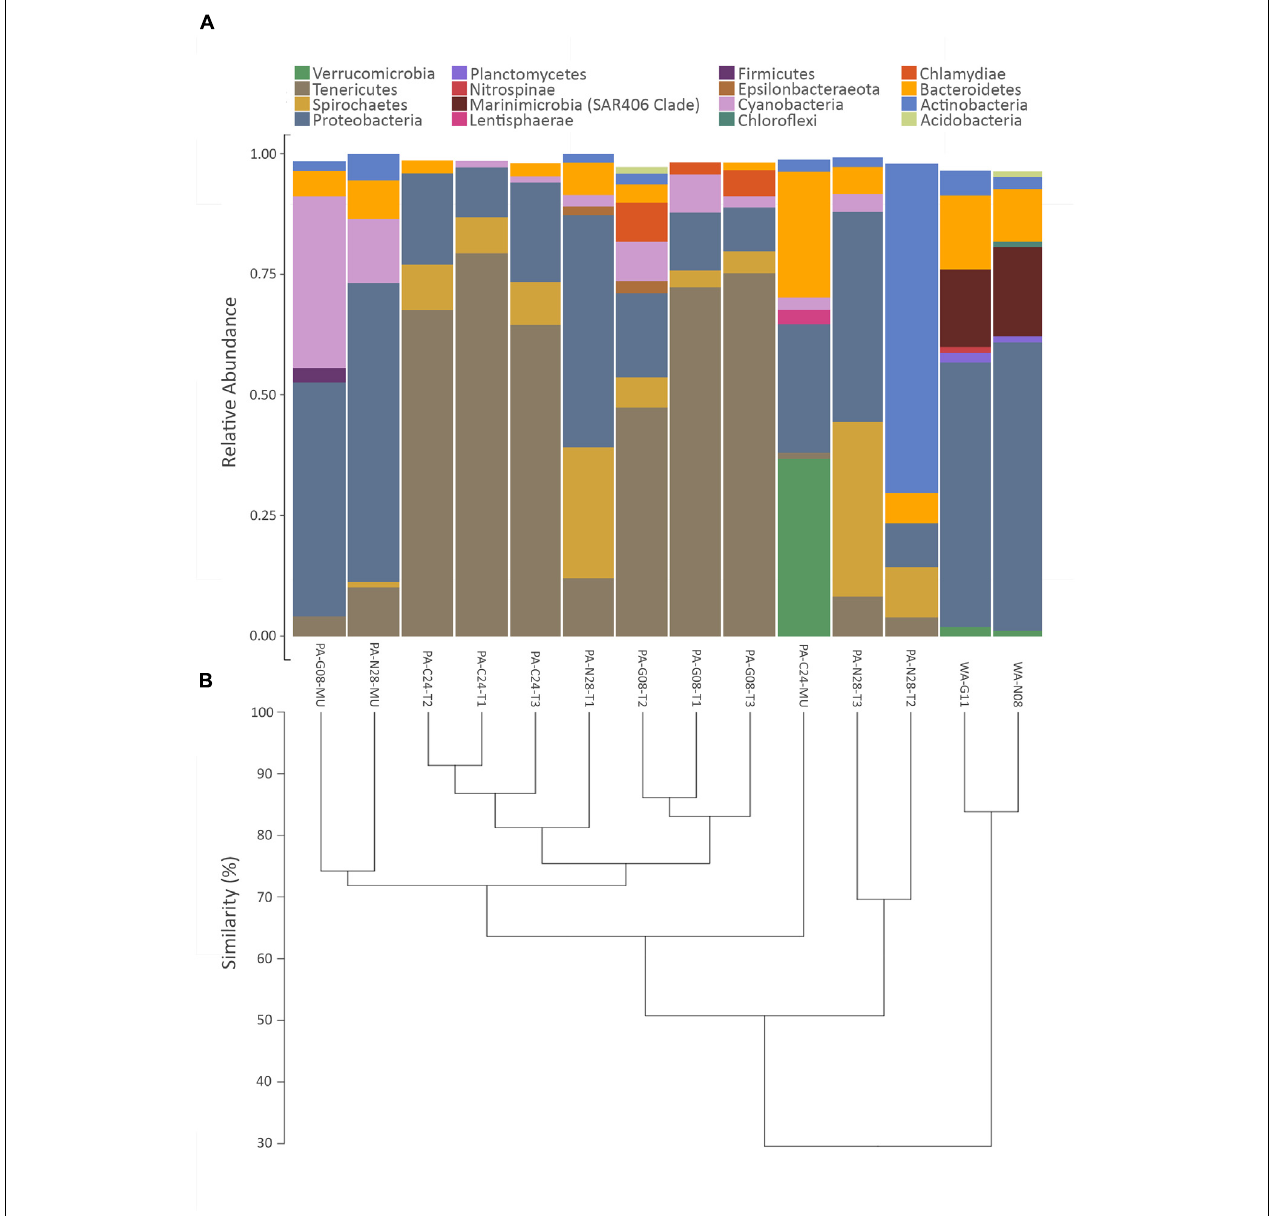
FIGURE 3 | Relative abundance of bacterial phyla and hierarchical dendrogram. (A) X -axis represents samples of Paragorgia arborea tissue and mucus, and seawater. Y -axis represents the most dominant bacterial phyla found within samples, with taxa contributing < 1% relative abundance excluded; and (B) hierarchical clustering dendrogram for P. arborea and reference seawater samples, developed from a Euclidian distance matrix produced from centered log-ratio (clr)-transformed compositional data. Sample names as in Table 1